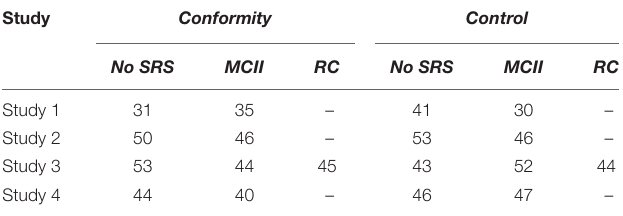
TABLE 1 | Number of participants per